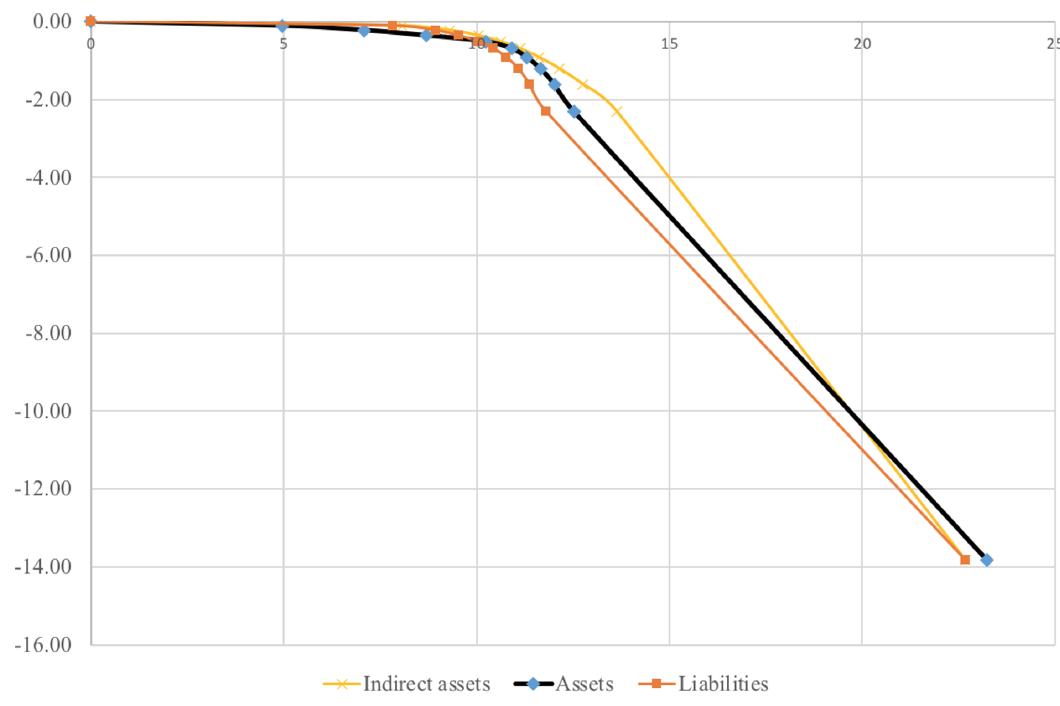
Figure 14. Analysis by